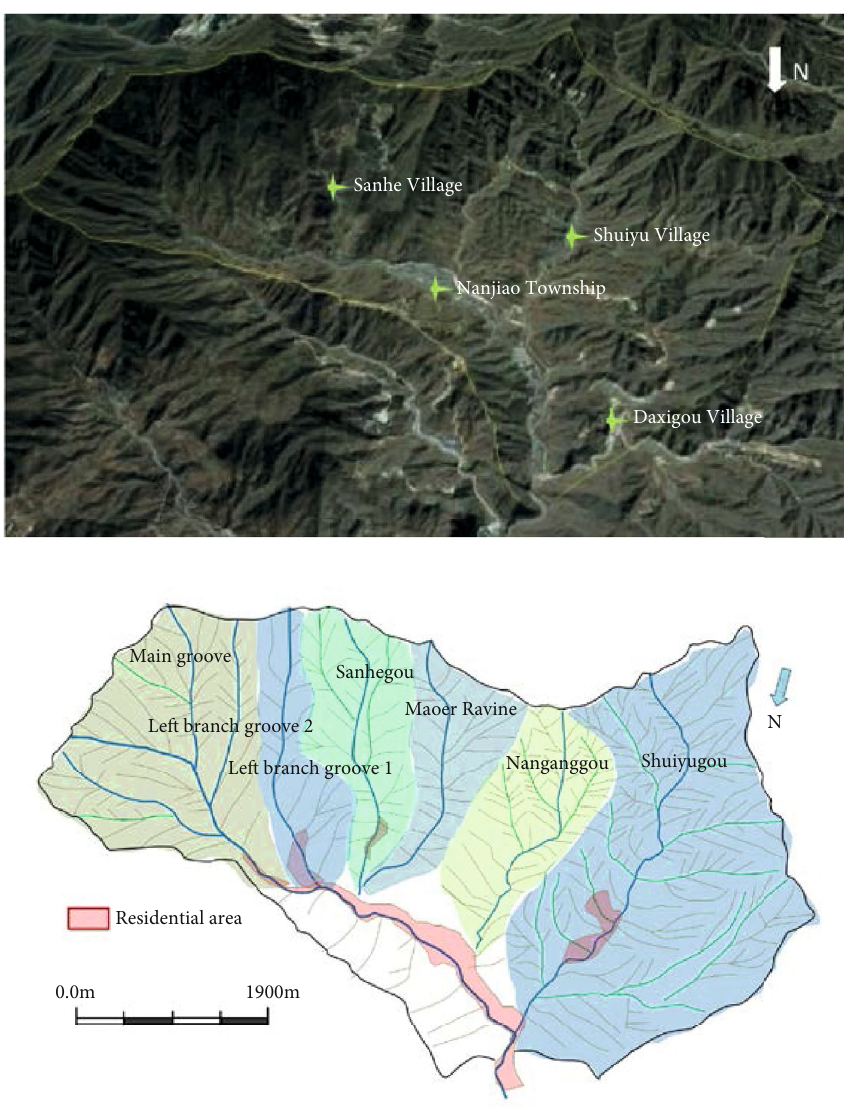
Figure 2: Image map and fl oor plan of Nanjiaogou small watershed.